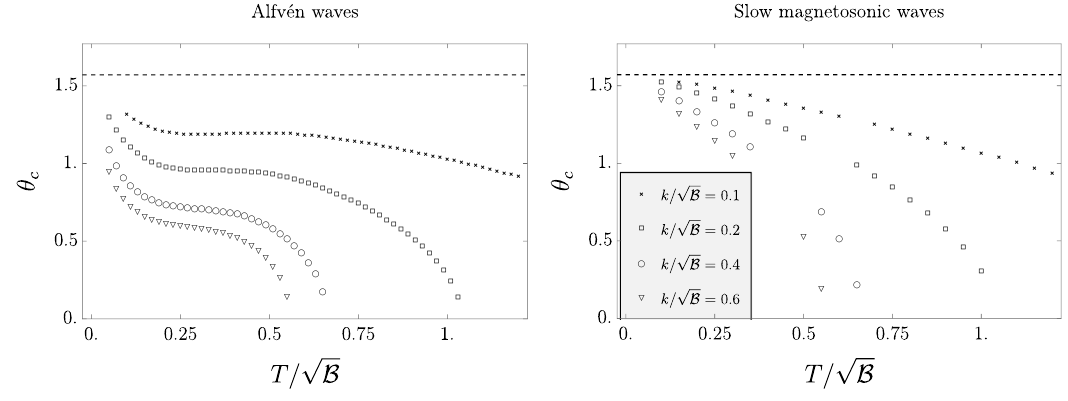
Figure 3 . The critical angle (cid:18) c for Alfv(cid:19)en waves (left) and slow magnetosonic waves (right), p p plotted as a function of T= B for k= B = f 0 : 1 ; 0 : 2 ; 0 : 4 ; 0 : 6 g . The dashed line at the top of both sub-(cid:12)gures indicates the value of (cid:18) c = (cid:25)=